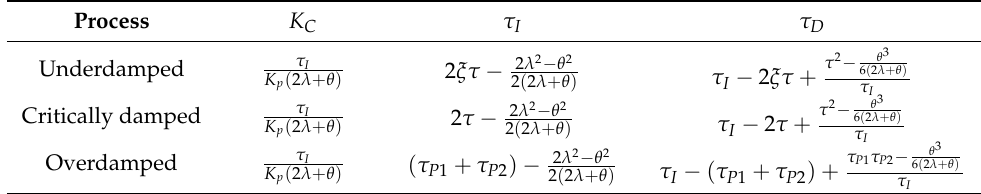
Table 1. PID Parameters for